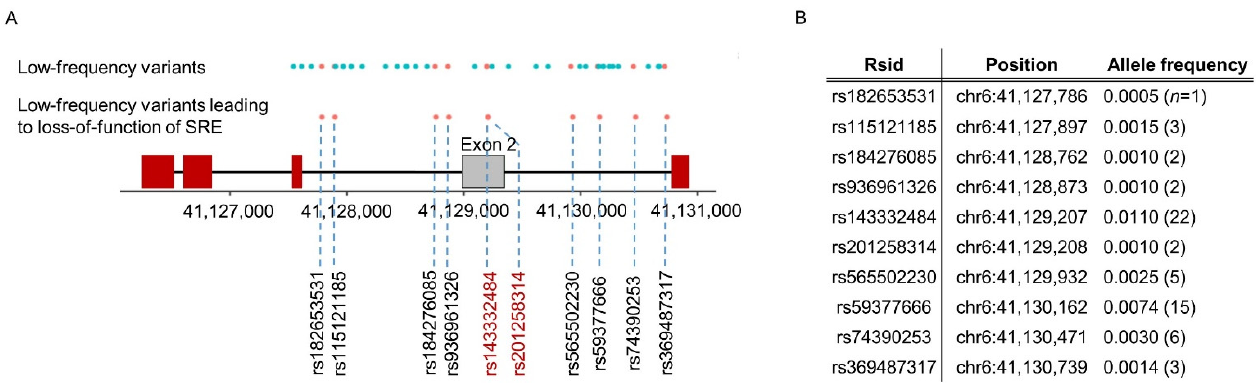
Figure 3. ( A ) Schematic depicting TREM2 exons and low-frequency variants within the exon 2 splicing unit. Cyan dots are low-frequency variants without predicted splicing impact, and red dots are low-frequency variants leading to loss of SRE function (functional variants). ( B ) Details of low-frequency variants potentially affecting exon 2 splicing.